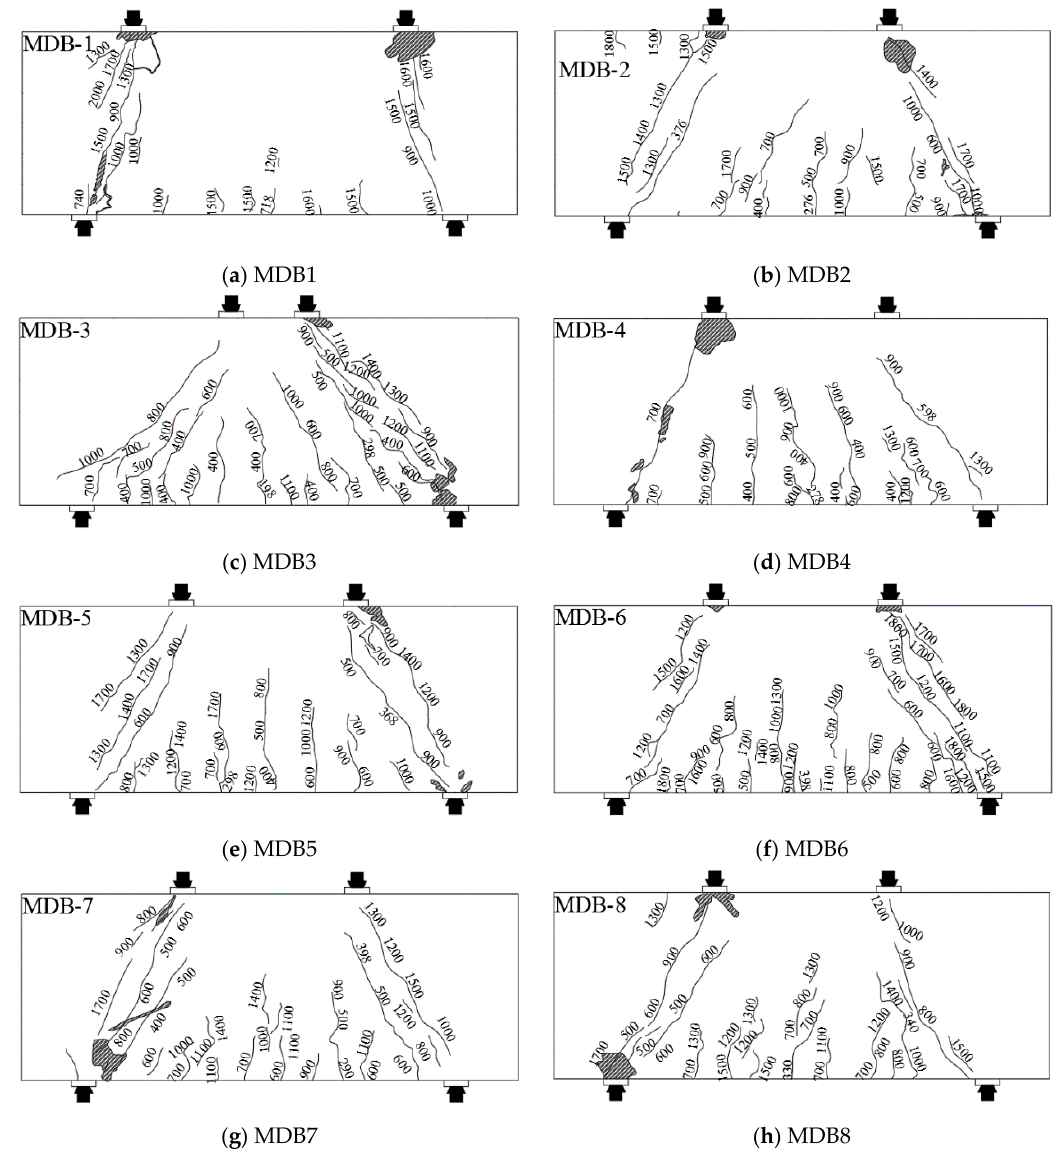
Figure 4. Crack patterns at failure.